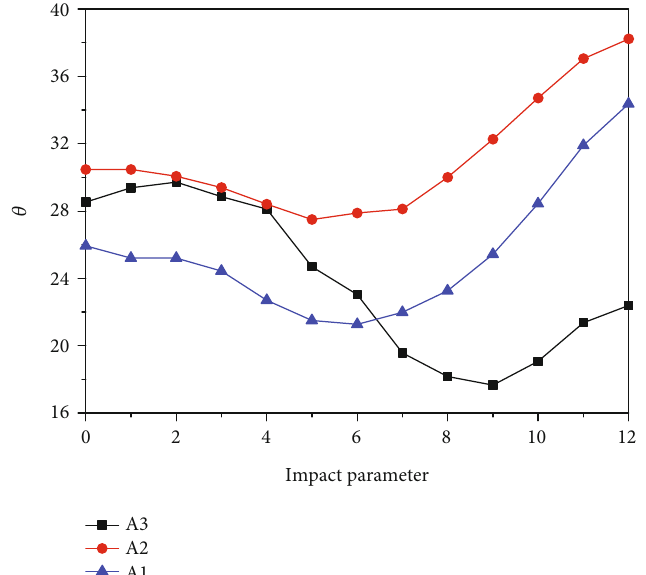
Figure 2: Correlation between θ and the impact parameter. The black-square, red-dot and blue-triangle lines express separately the angle of θ about the maximum, medium and minimum fragments in the ternary